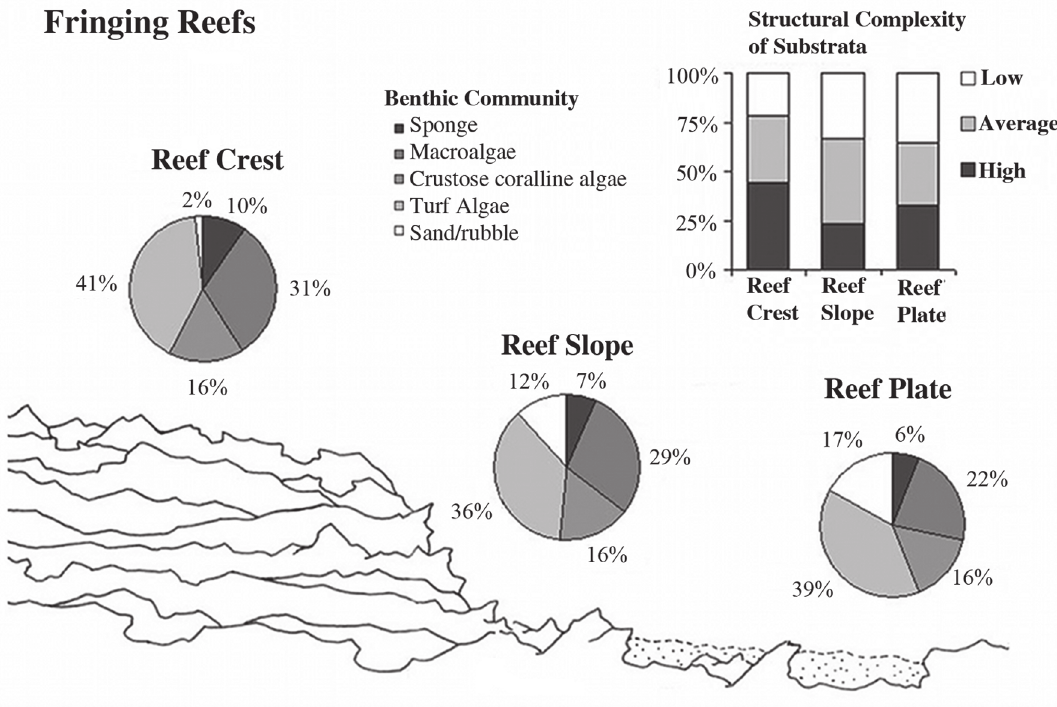
Fig. 2. Diagram showing profiles of fringing reefs of Trindade Island, Brazil. Benthic cover and substrate structural complexity of each habitat are